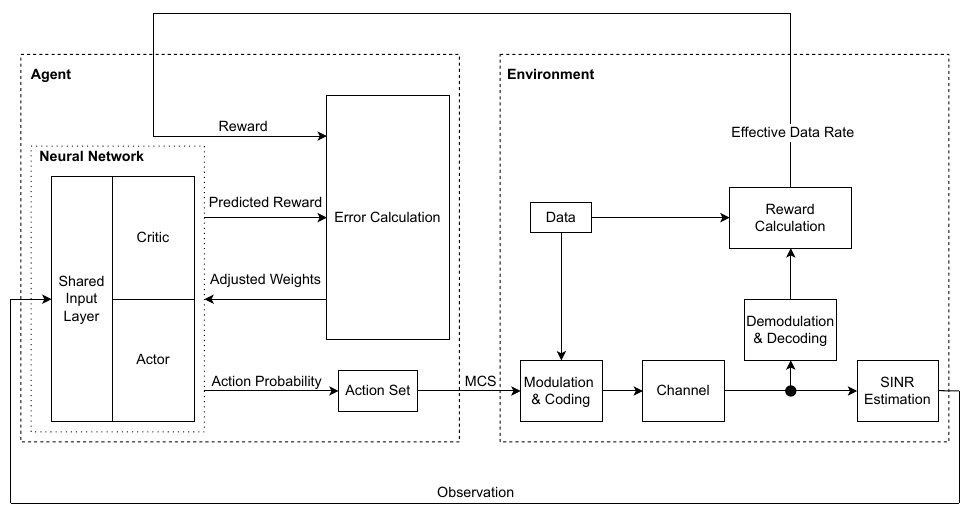
Figure 3. Block diagram showing the proposed approach during training with the underlying mechanics of agent and